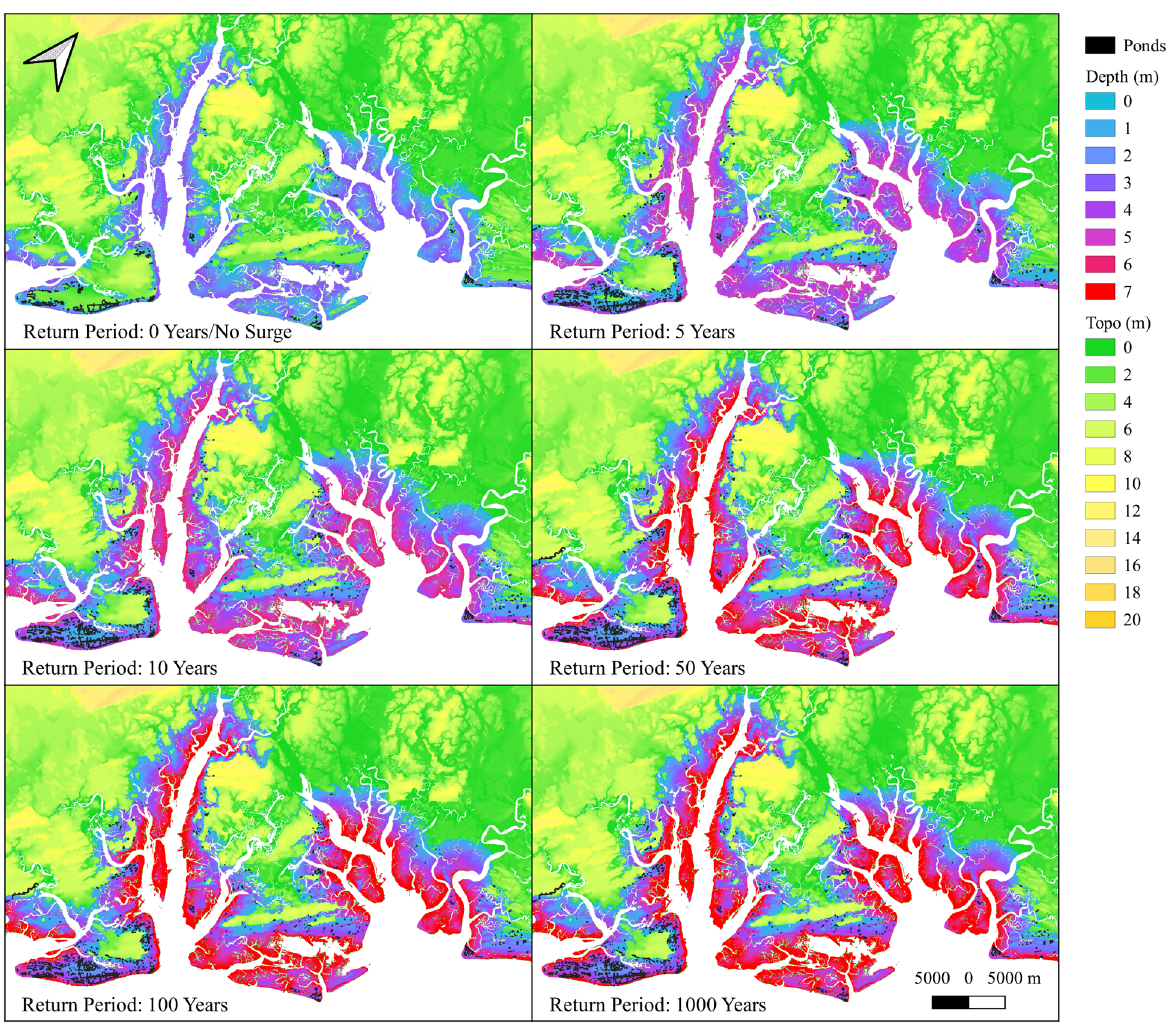
Figure 10. Beaufort County area inundation map (blue–red) caused by storm surge heights with different return periods under an SLR scenario of 2.0 m. The SMPs at risk are shaded black.